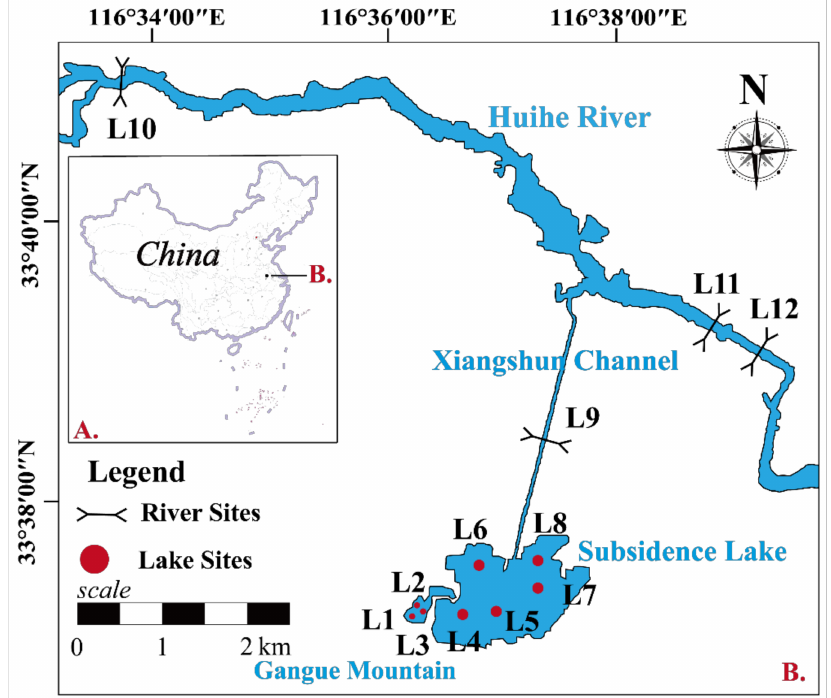
Figure 1. Map of sampling sites in the coal mining subsidence lake and its connected